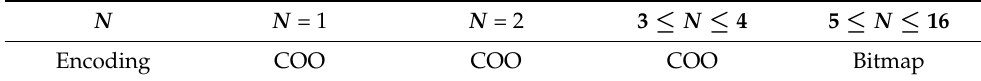
Table 2. The encoding scheme of the proposed SPEC with different values of N and M = 16. N N = 1 N = 2 3 ≤ N ≤ 4 5 ≤ N ≤ 16 Encoding COO COO COO Bitmap The Weight Decoder unit in Figure 3 decodes the compressed non-zero weights.